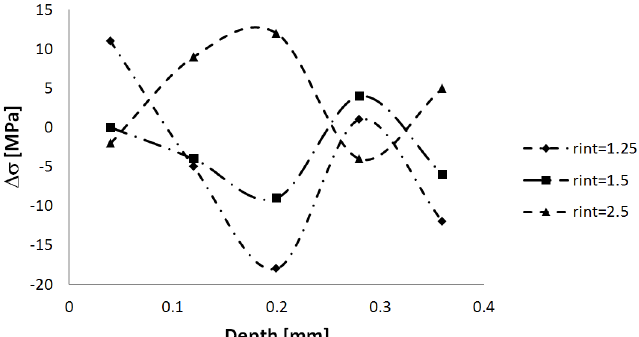
Figure 7: Plot of the difference in terms of measured stress at different depths. The difference are calculated for three different values of the internal radius with respect to the reference value r int